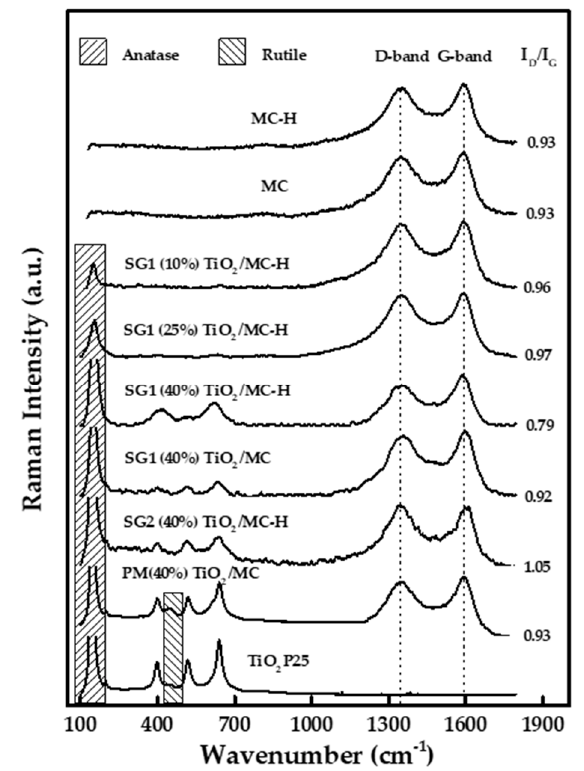
Figure 3. Raman spectra of some of the solids used in the present study.